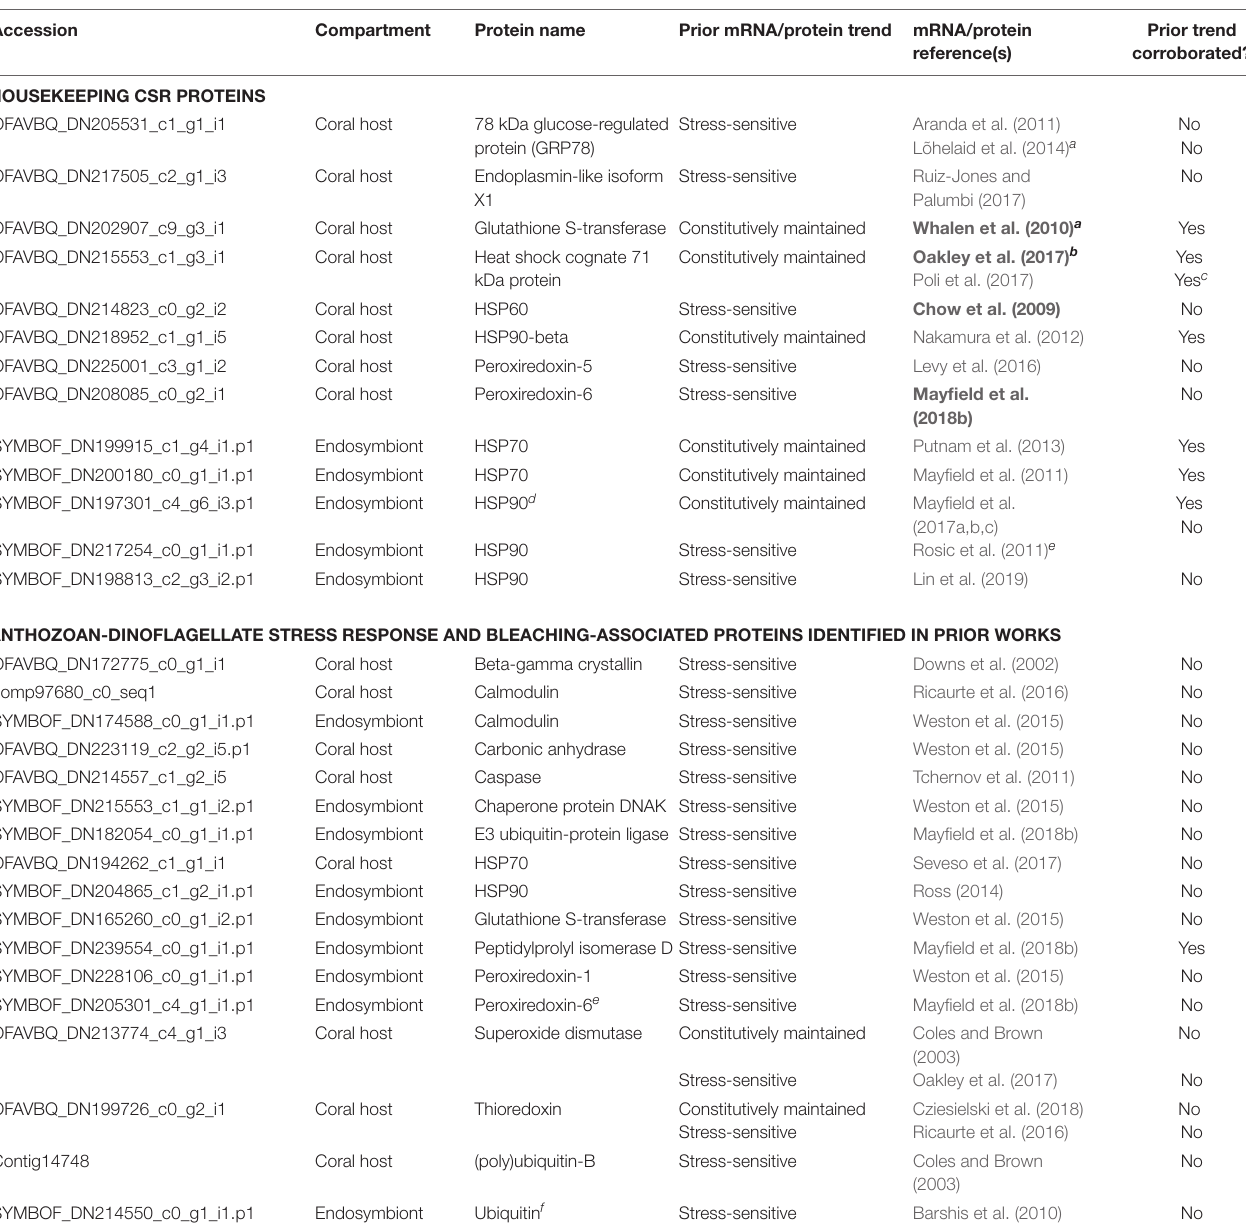
TABLE 5 | Select stress response “housekeeping” proteins, stress-sensitive proteins involved in the canonical eukaryotic stress response (CSR), and anthozoan-dinoflagellate bleaching-associated proteins identified in prior works.